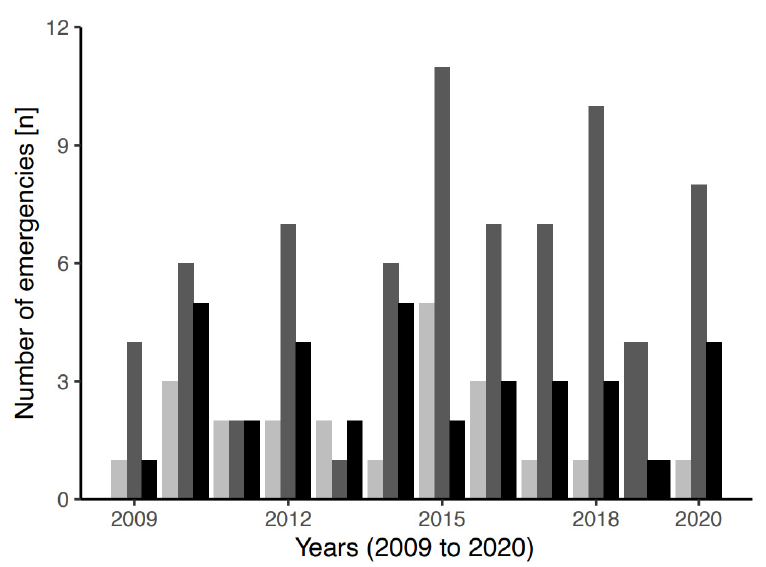
Figure 2. Number of emergencies due to alpinists being lost over the observational period (2009–2020) stratified by group size. Color coding: light grey, solo; grey, as a couple; black, in a group of three or more.